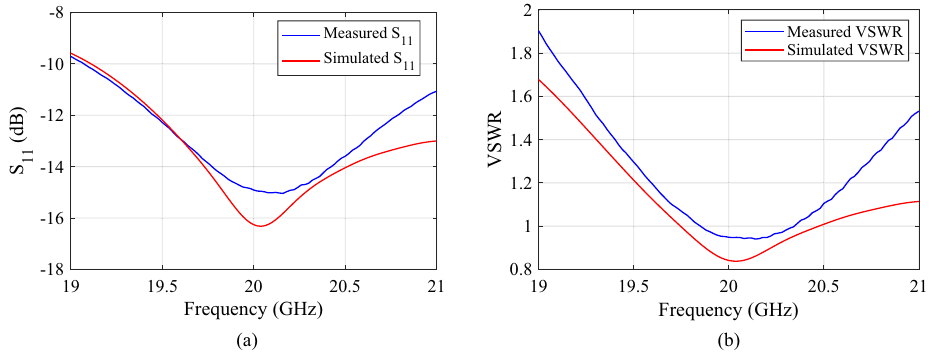
Figure 15. Comparing measured and predicted S 11 and VSWR of the base antenna (truncated single layer RCA).